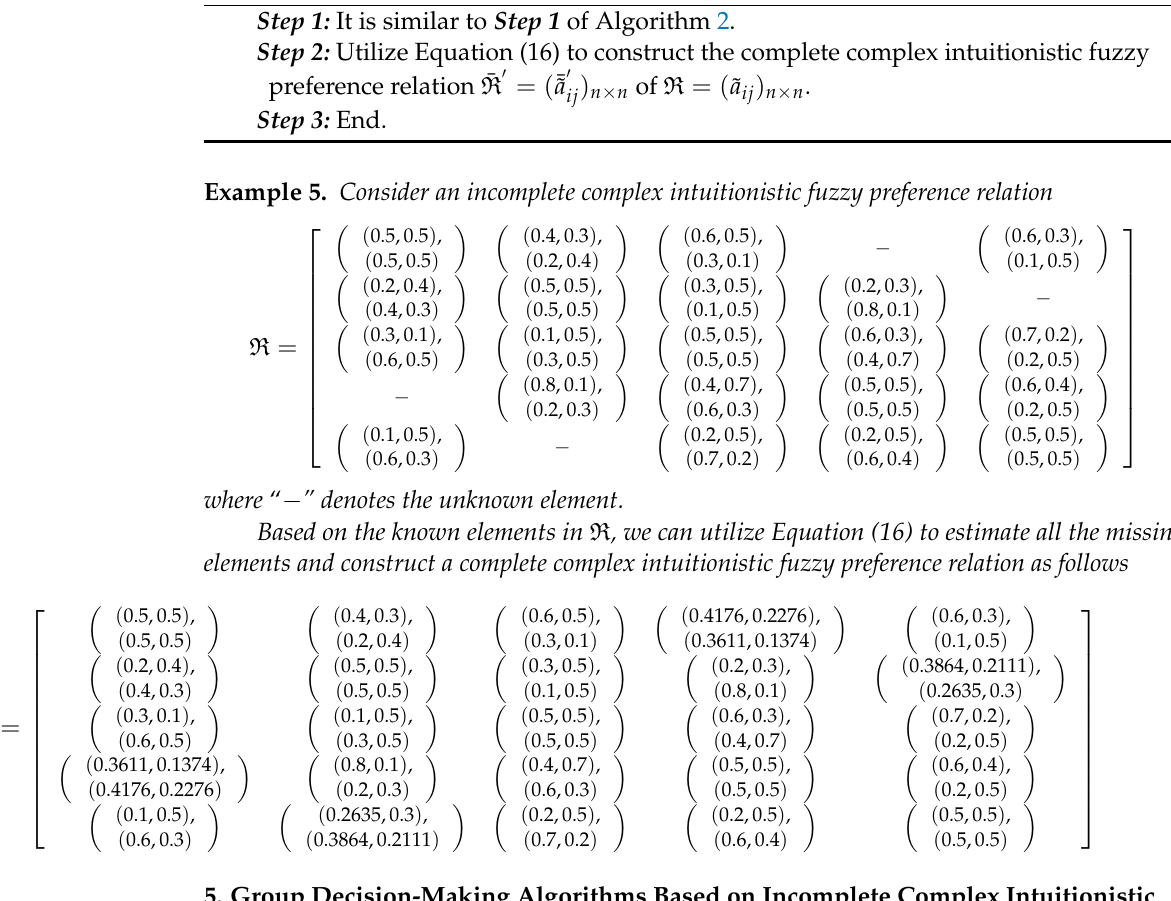
Algorithm 3: The estimation algorithm with more known judgments